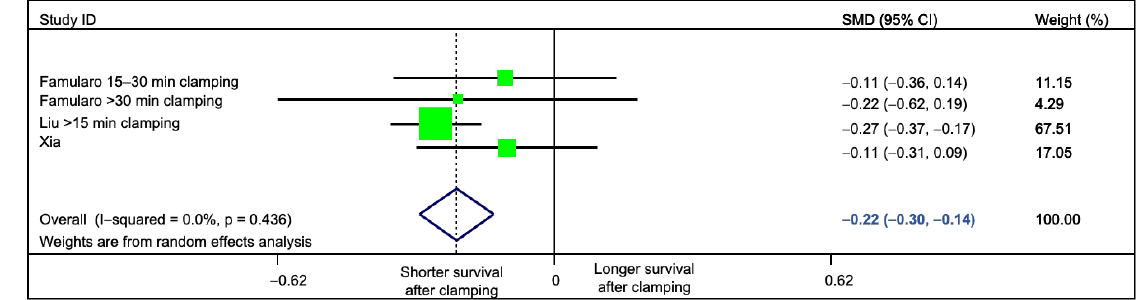
Table 3. Results of the sensitivity analyses.